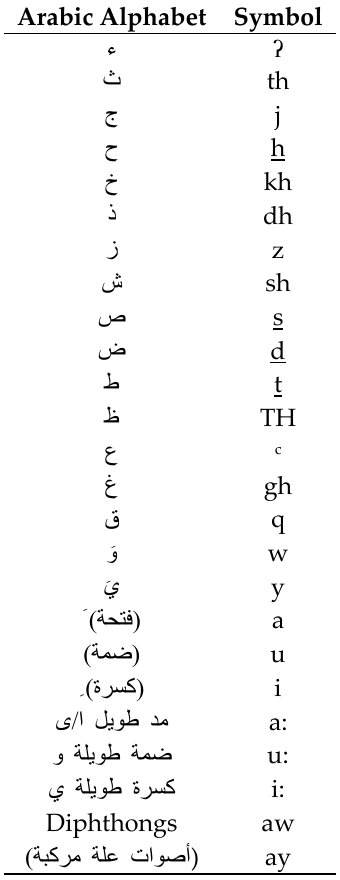
Table A1 provides the transliteration symbols for Arabic vowels and consonants. Table A1. Arabic transliteration symbols. Table A1. Arabic transliteration